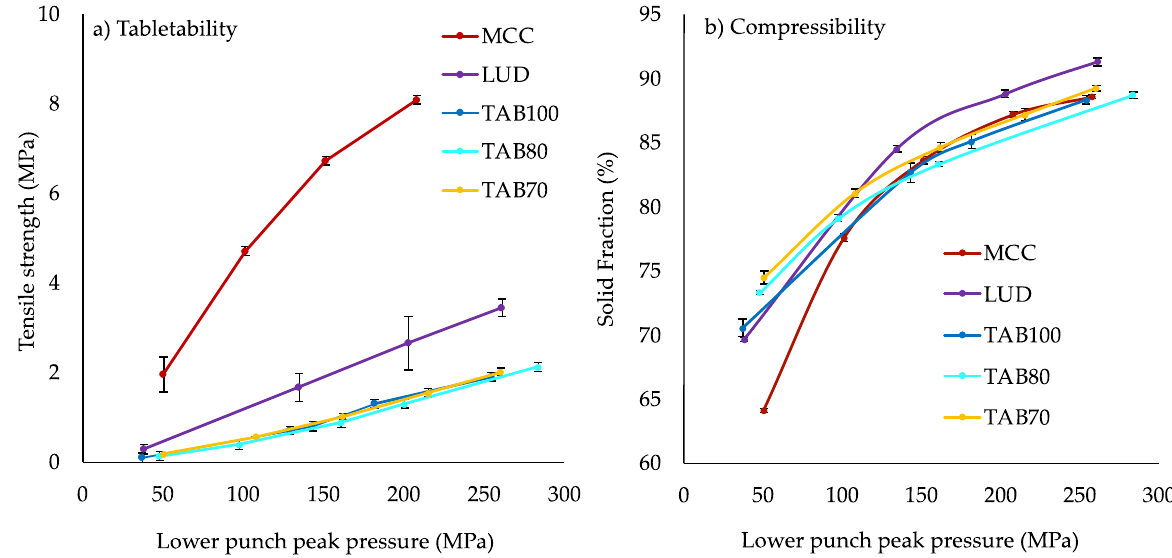
Figure 6. ( a ) Tabletability and ( b ) compressibility plots of excipients: MCC, LUD, TAB 70, 80 and 100 ( n = 10). ( n =